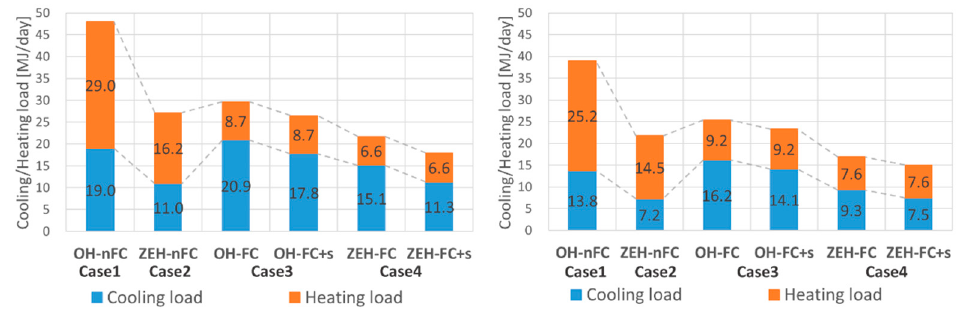
Figure 6. Daily mean cooling and heating load (left: living room, right: bedroom).